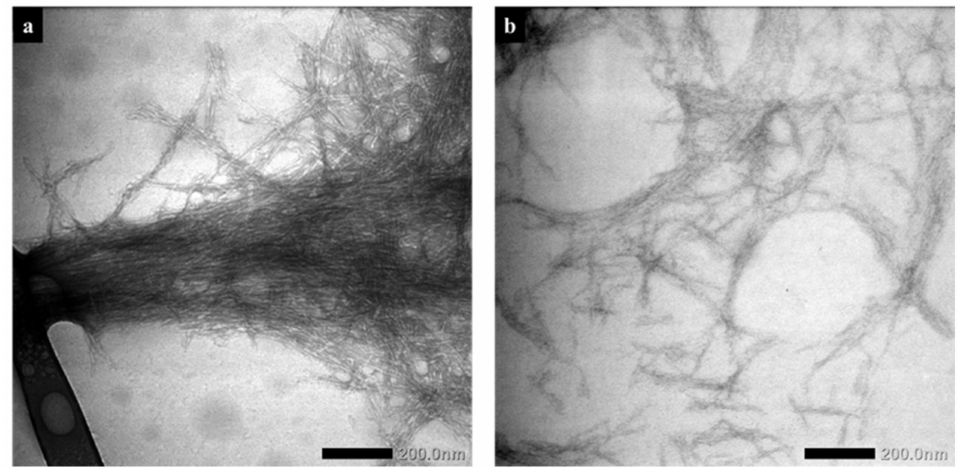
Figure 5. TEM images of CNCs produced at different APS concentrations: ( a ) 1.5 M; ( b ) 1.9 M.